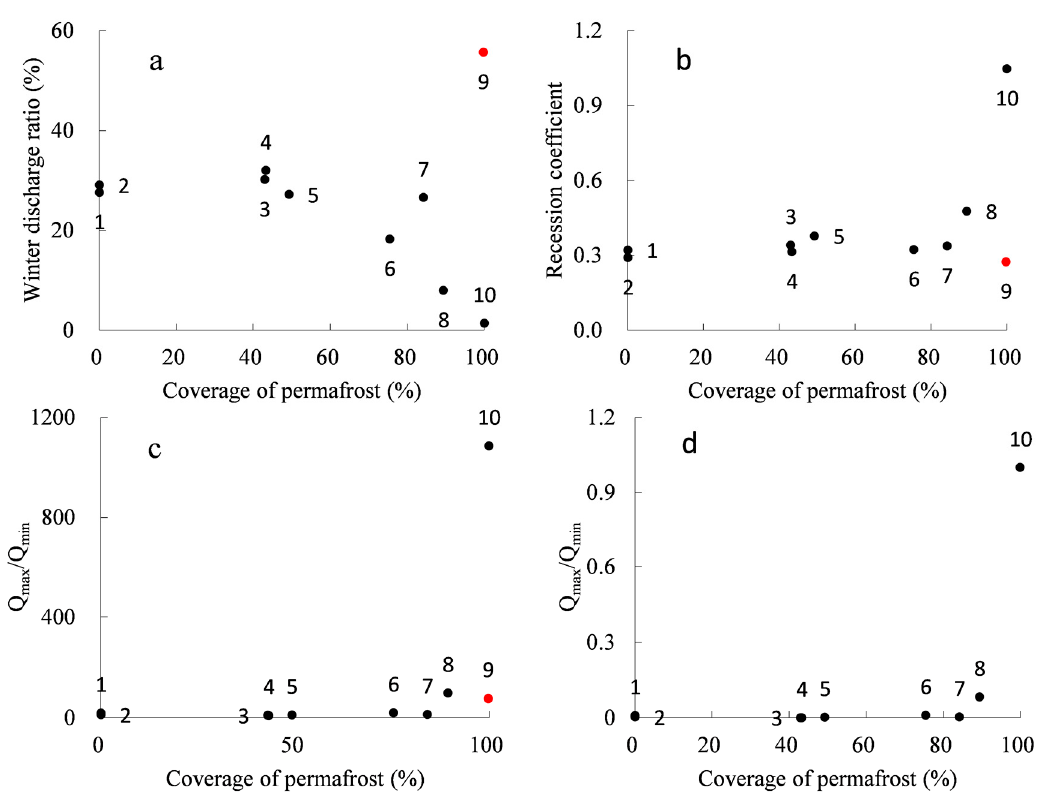
Figure 2. Relation between the hydrological variables and coverage of permafrost for 10 catchments (1–10). Codes are listed in Table 1. The red dot indicated the outlier catchment (code 9). ( a – c ) indicated the relationship between winter discharge ratio and permafrost coverage, recession coefficient and permafrost coverage, the ratio of Q max /Q min and permafrost coverage, respectively. ( d ) is ( c ) but without code 9 and Y-axis normalized.